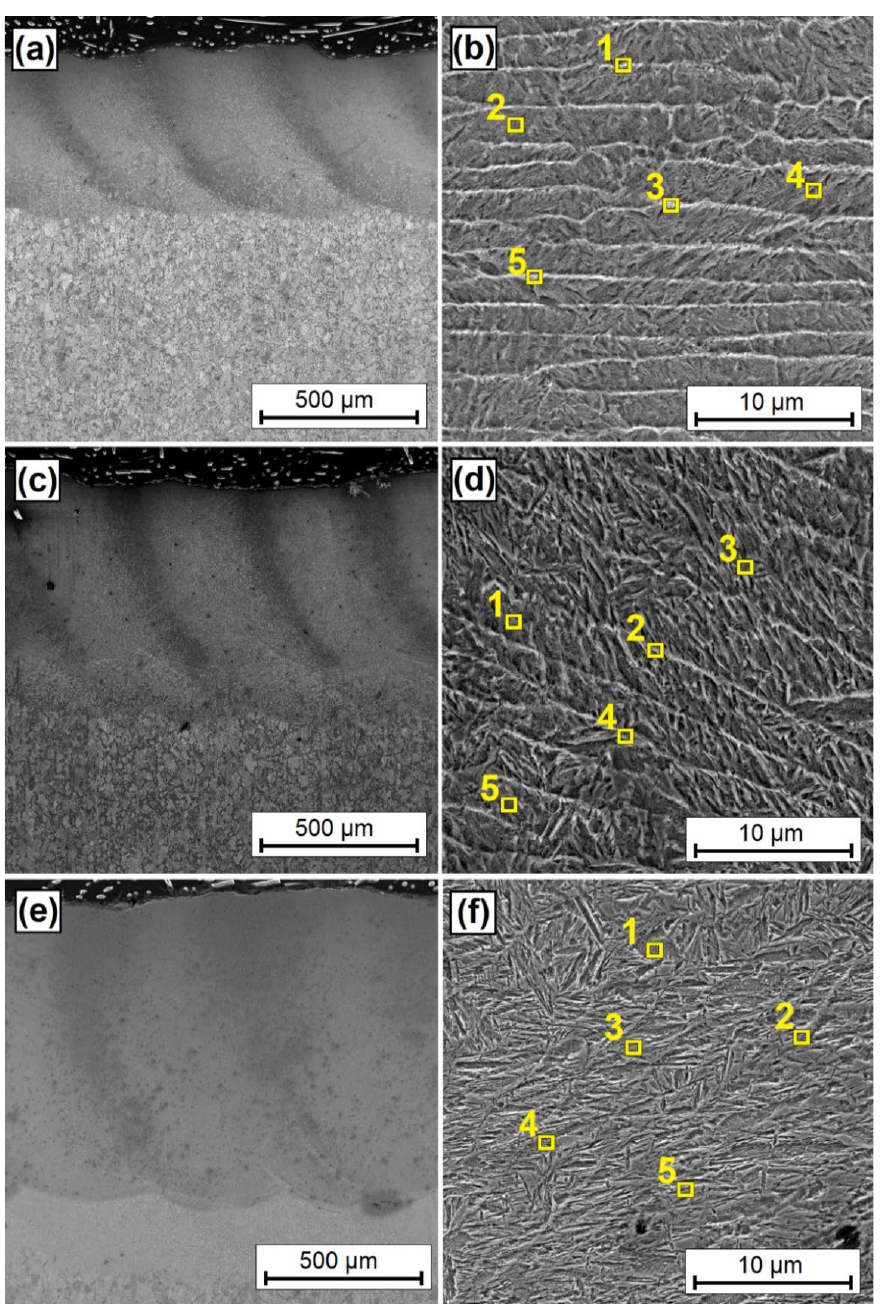
Figure 6. Microstructure of multiple laser tracks for various laser beam powers: ( a ) 500 W, ( b ) the magnification of the middle area of the specimen produced using 500 W and ( c ) 900 W, ( d ) the magnification of the middle area of the specimen produced using 900 W and ( e ) 1100 W, ( f ) the magnification of the middle area of the specimen produced using 1100 W. All photos were taken in SE contrast, in high vacuum at a voltage of 10 kV.